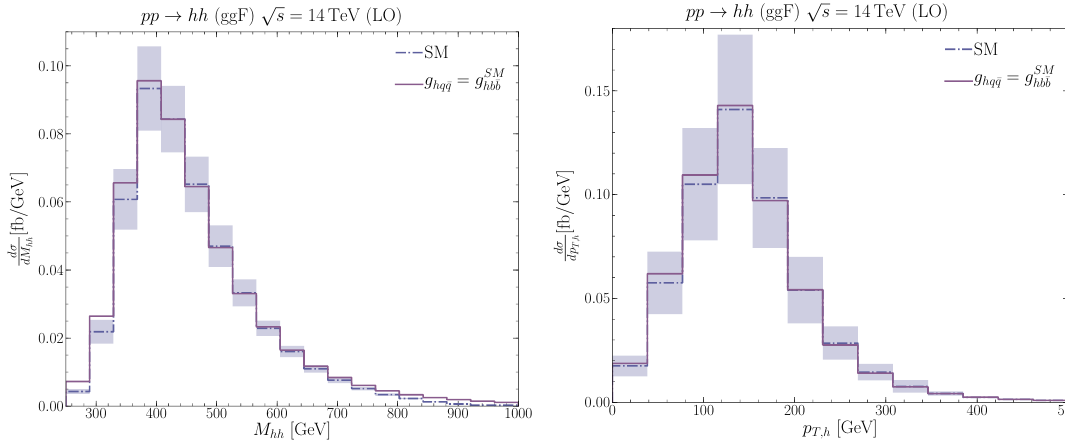
Figure 4 . Left: the di-Higgs invariant mass di(cid:11)erential cross section d(cid:27)=dM hh for the SM at LO and the benchmark point toy. The error boxes denote the total scale, PDF and (cid:11) s uncertainties. Right: the same but for the Higgs transverse momentum p T;h